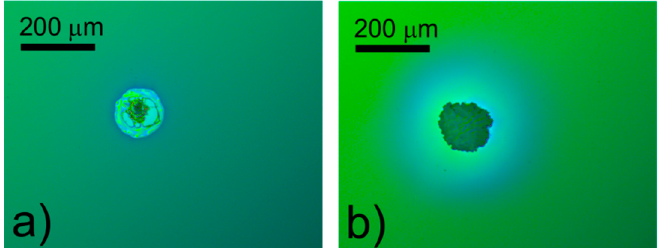
Figure 8. Typical microscopic pictures of damage sites of ( a ) a sample pre-cleaned with an alcoholic solution (A-CP1, 20 J/cm 2 ) and ( b ) a sample that was not pre-cleaned (A-CP2, 13 J/cm 2 ).